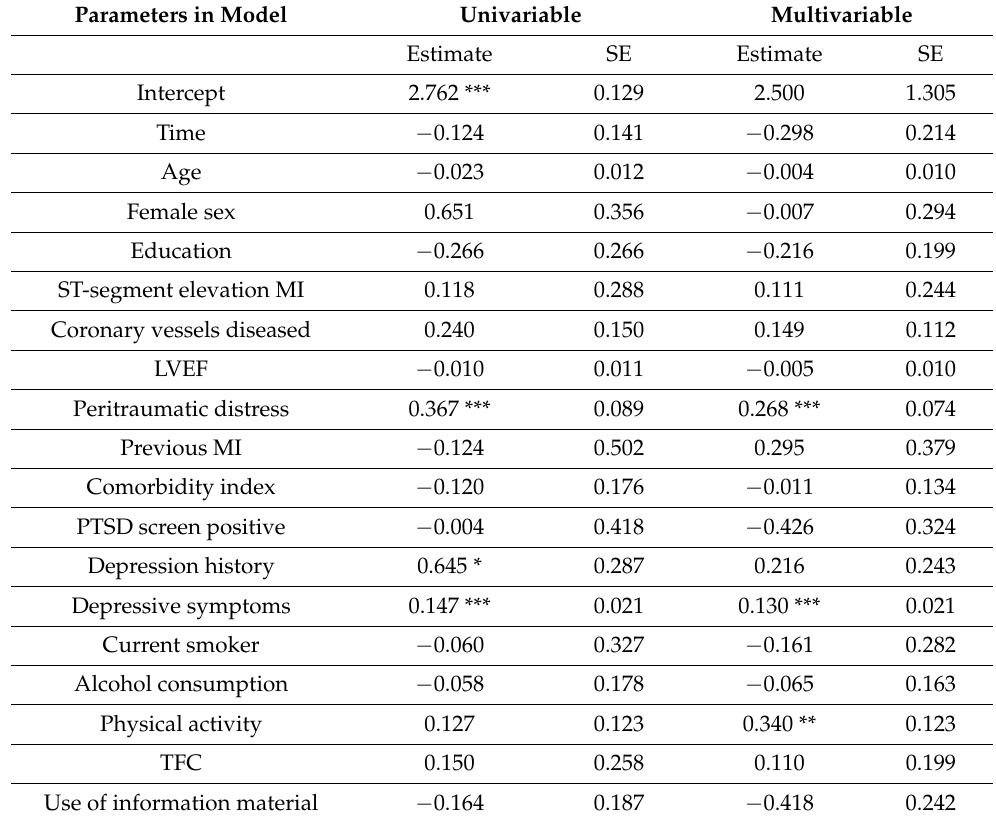
Table 2. Relationships with PTSD symptoms over 12